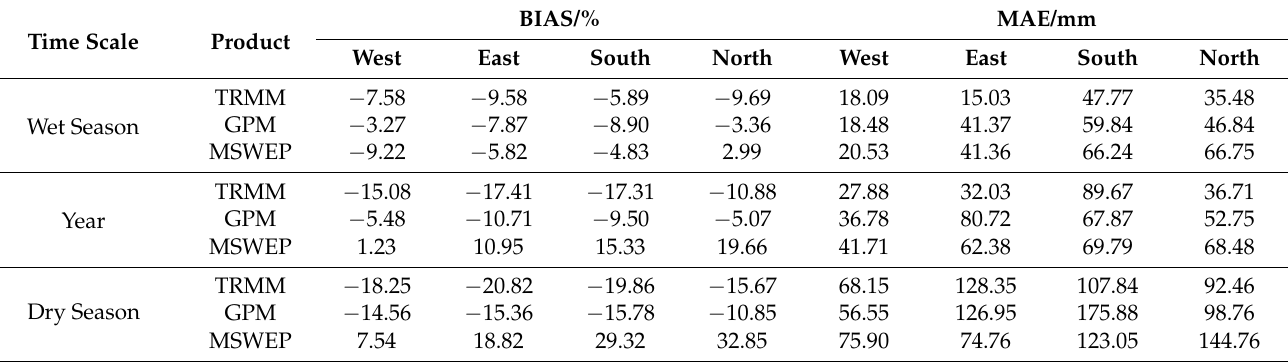
Table 2. Annual scale evaluation indexes of precipitation products BIAS and